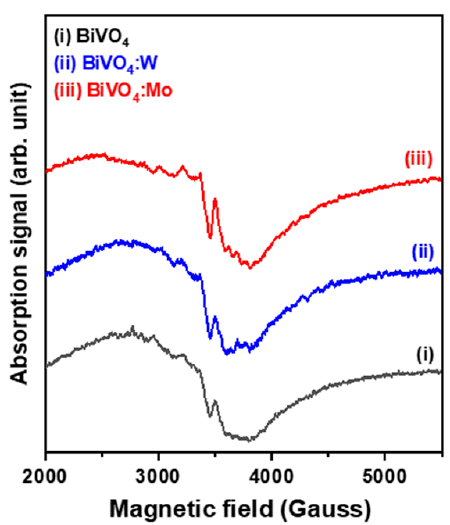
Figure 4. ESR spectra of undoped and impurity-doped BiVO 4 powder samples.